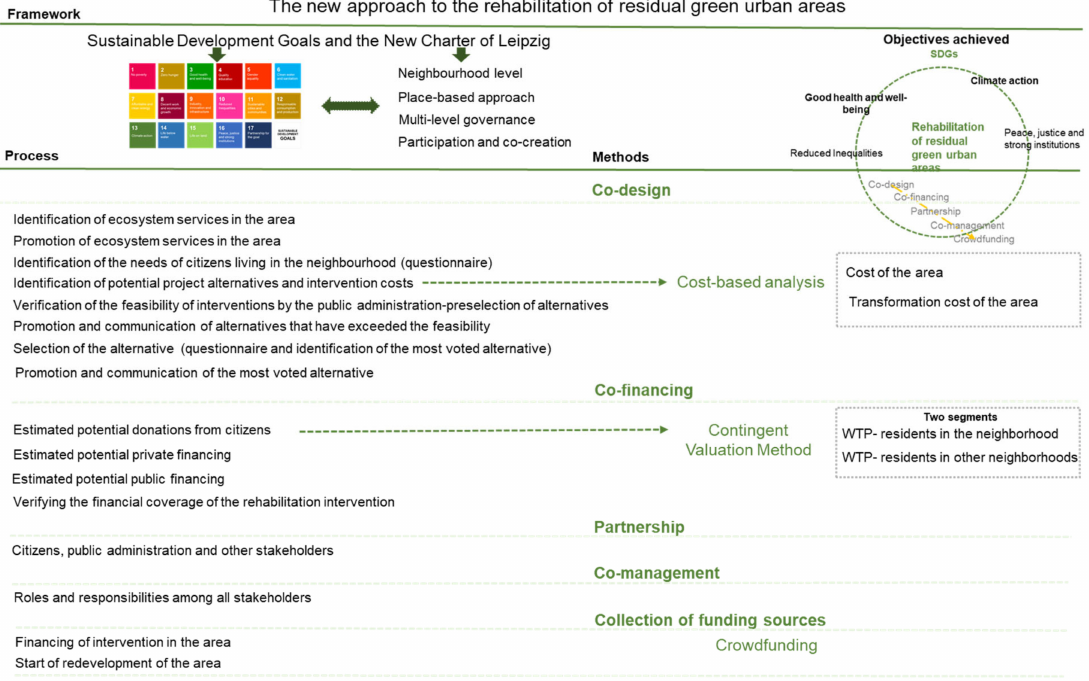
Figure 2. Flowchart—steps of research